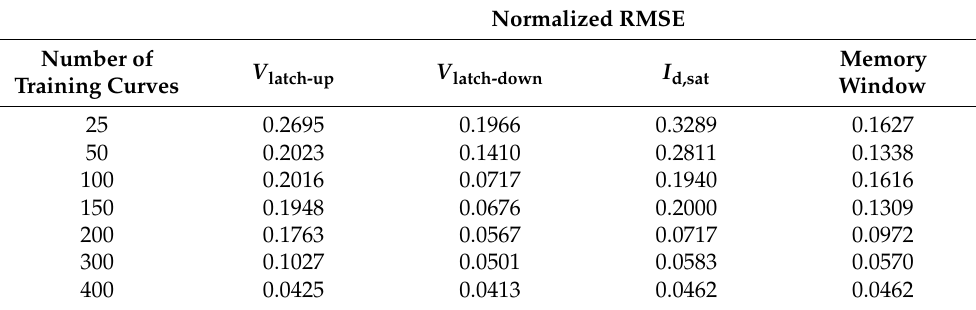
Table 3. Error rate as a function of the number of I-V curves in the dataset for the prediction of device